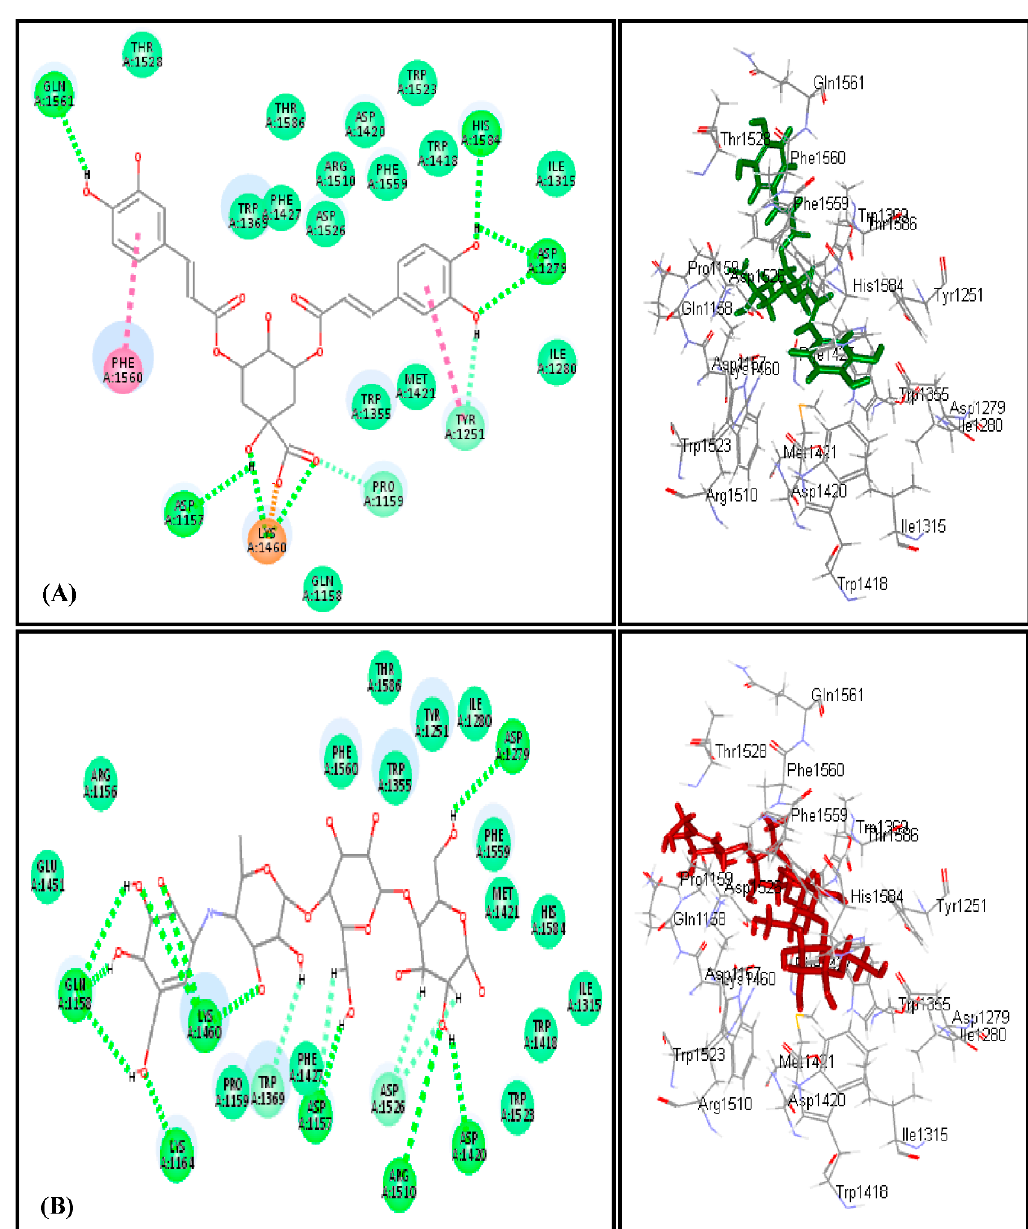
Figure 6. 2D and 3D binding modes of dicaffeoylquinic acid ( A ) and acarbose ( B ) within human glucosidase (HG) active centers employing C-docker protocol. Table 6. Free binding energies ( ∆ G) of the major identified compounds with human α -amylase (HA) and human α -gluco- sidase (HG) enzymes active centers using molecular docking with pH- and rule-based methods and expressed in kcal/mol.